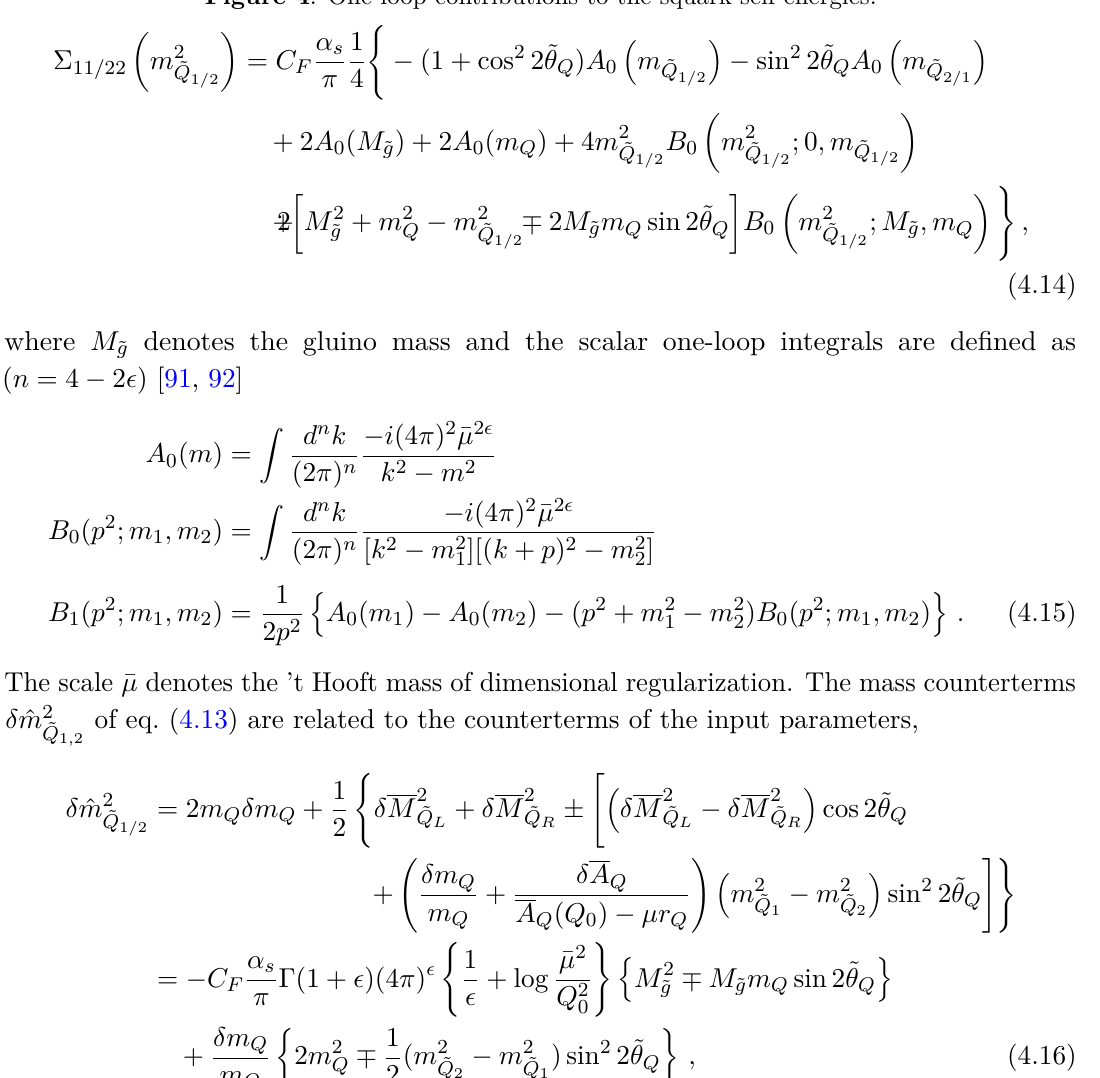
Figure 4 . One-loop contributions to the squark